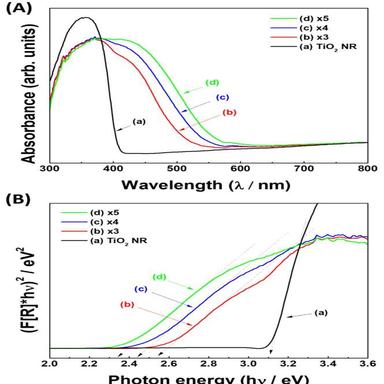
(A) UV–Vis absorption spectra and (B) Tauc plot of (a) bare TONR/FTO, (b) (×3)-CdIS/TONR/FTO, (c) (×4)-CdIS/TONR/FTO, and (d) (×5)-CdIS/ TONR/FTO.